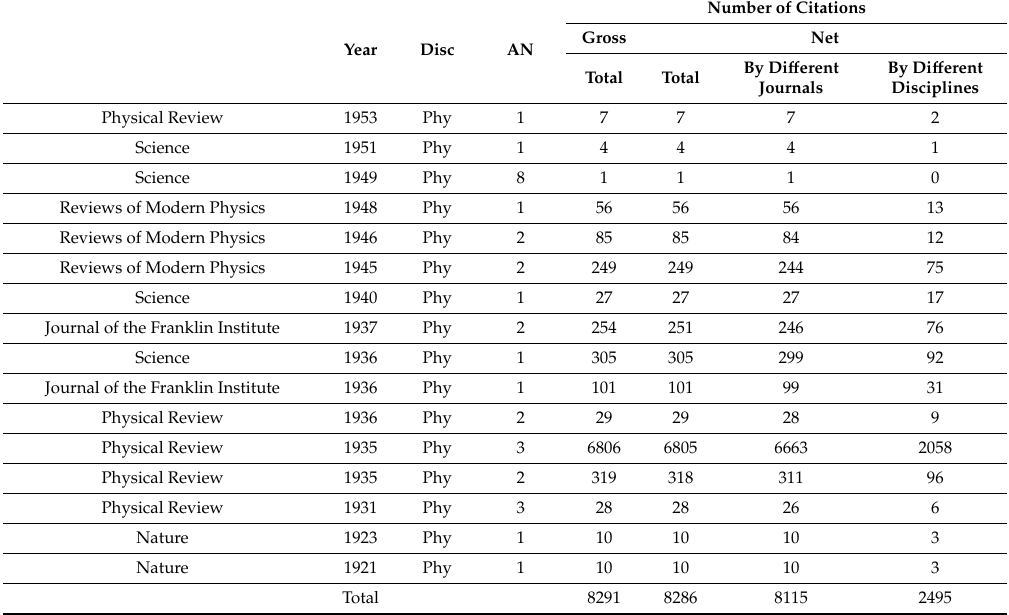
Table A4. Descriptive statistics and Scopus categories for the third analyzed PH, as a representative intradisciplinary and intertopical orthodox PH. Each row represents a single publication; multiple publications in the same journal and same year are represented by separate rows. Note that in contrast with the other two PHs, all publications by this author occurred before